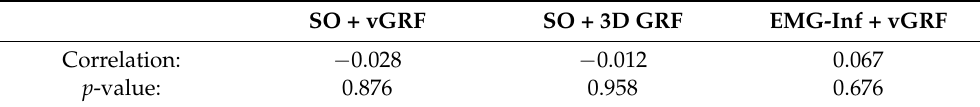
Table 2. Kendall’s rank correlation of peak ACL force between EMG-informed + 3D GRF and each different modelling approach for the drop–land–jump